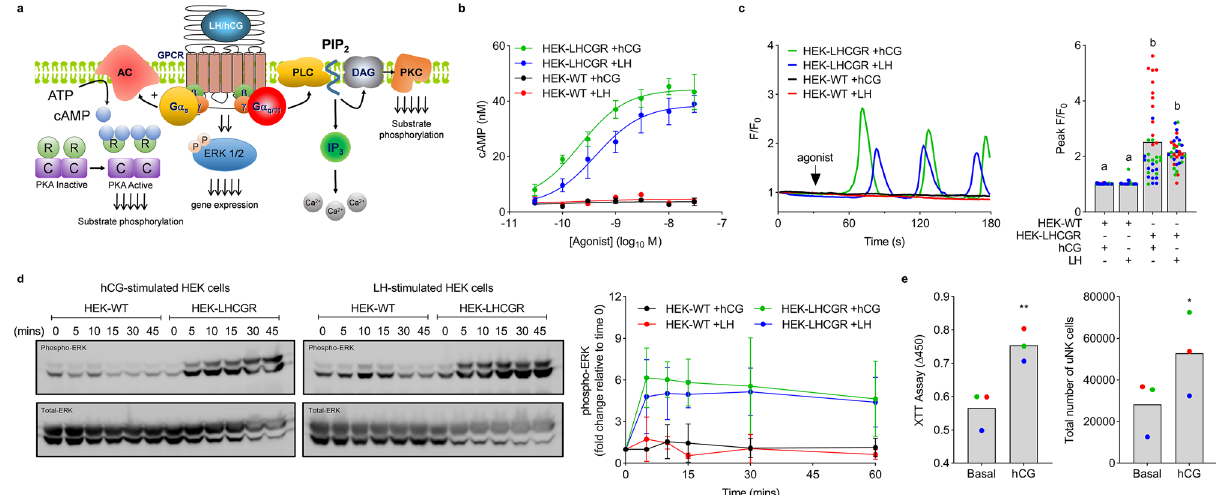
Figure 2. hCG and LH are bioactive. ( a ) Schematic representation of signalling pathways downstream of LHCGR. ( b ) Concentration-dependent cAMP responses to hCG and LH in HEK-WT and HEK-LHCGR cells. ( c ) Representative Ca 2+ traces in HEK-WT and -LHCGR cells after treatment with 1 µM hCG or LH. Data are shown as fold change in fluorescence relative to time point 0 (F/F 0 ) and represent one individual cell. Mean peak responses from 36 cells analysed from 3 separate cultures (denoted as separate colours) are shown in the right panel with differing letters indicating significance between groups ( P < 0.05), (ANOVA and Tukey’s multiple comparison test). ( d ) Representative western blots showing levels of phospho-ERK in HEK-WT and -LHCGR cells challenged with either 10 nM hCG or LH (left panels). Levels of phospho-ERK were normalized to total- ERK and shown as a fold change relative to unstimulated cells (time point 0) (right panel). Data are mean ± SD, n = 3. ( e ) Impact of 10 nM hCG on uNK cell proliferation as measured by XTT assay (left panel) and cell counting (right panel). Individual data points from 3 biological replicates are shown with bars denoting mean values. Significance was determined by paired t-test with * P < 0.05 and ** P <